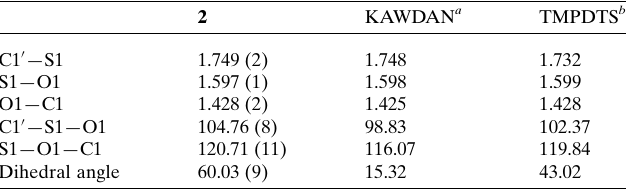
Table 2 Selected structural parameters of compound 2 compared with closely related structures.